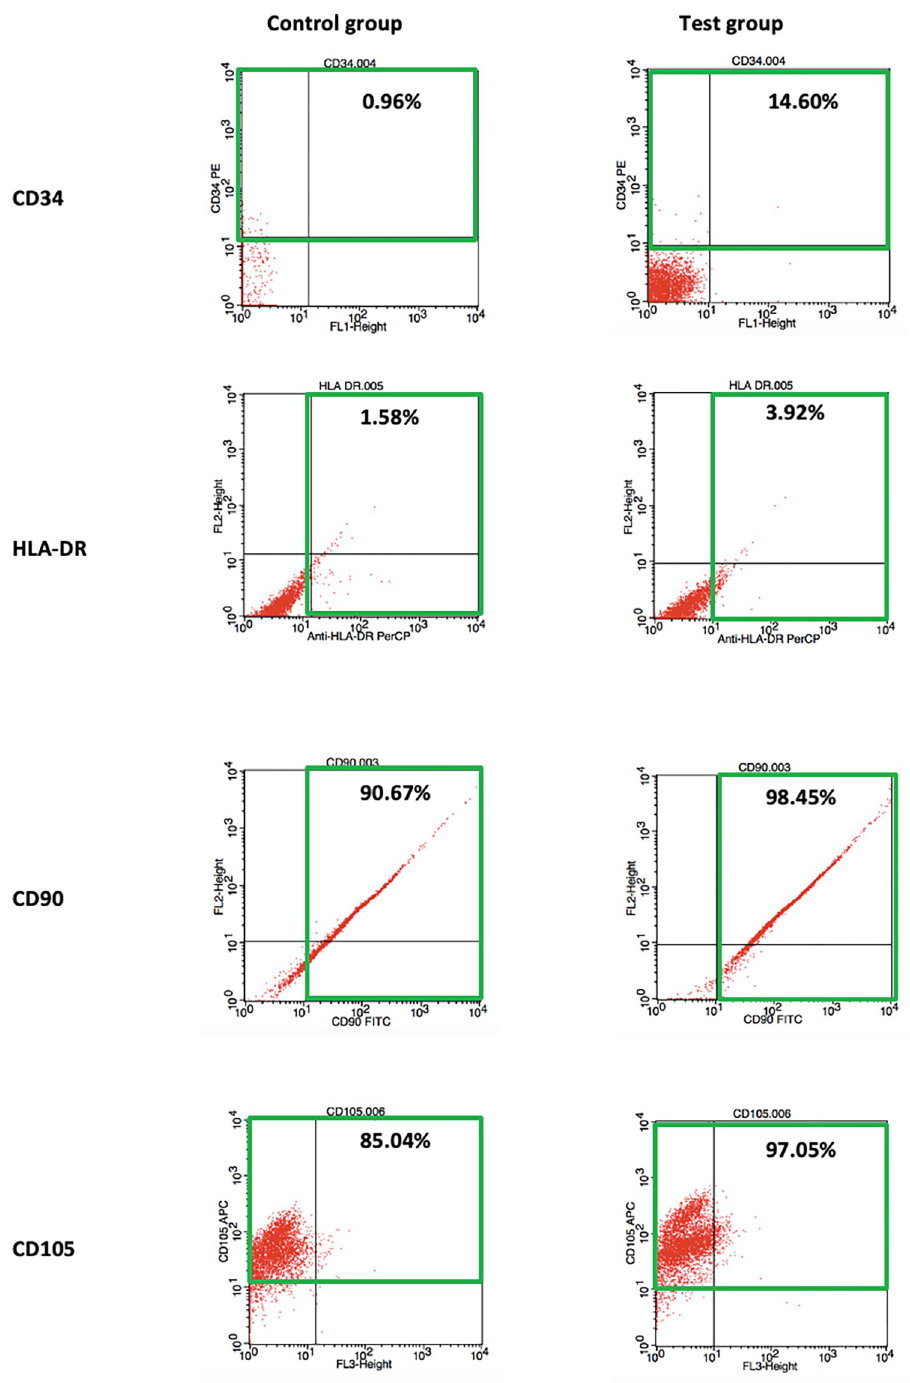
Fig 6. The expression of cell surface markers CD34, HLA-DR, CD90, and CD105 for the control and test groups (positive finding: Within highlighted green